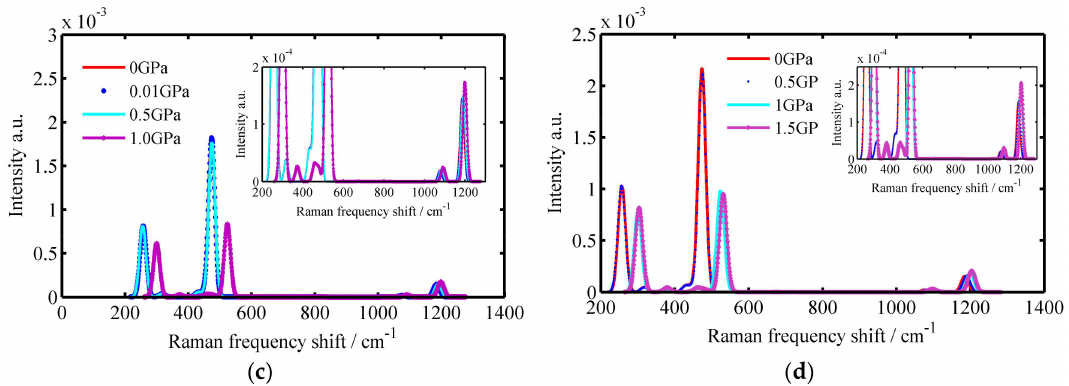
Figure 5. The Raman spectrums of β -SiO 2 crystal under di ff erent pressure and temperature. ( a ) 527 K, ( b ) 727 K, ( c ) 1127 K, ( d ) 1527 K.